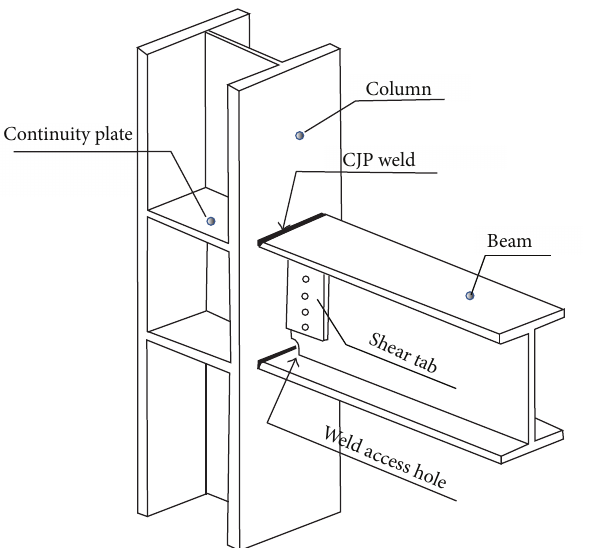
Figure 1: Typical pre-Northridge beam-to-column moment con- nection.